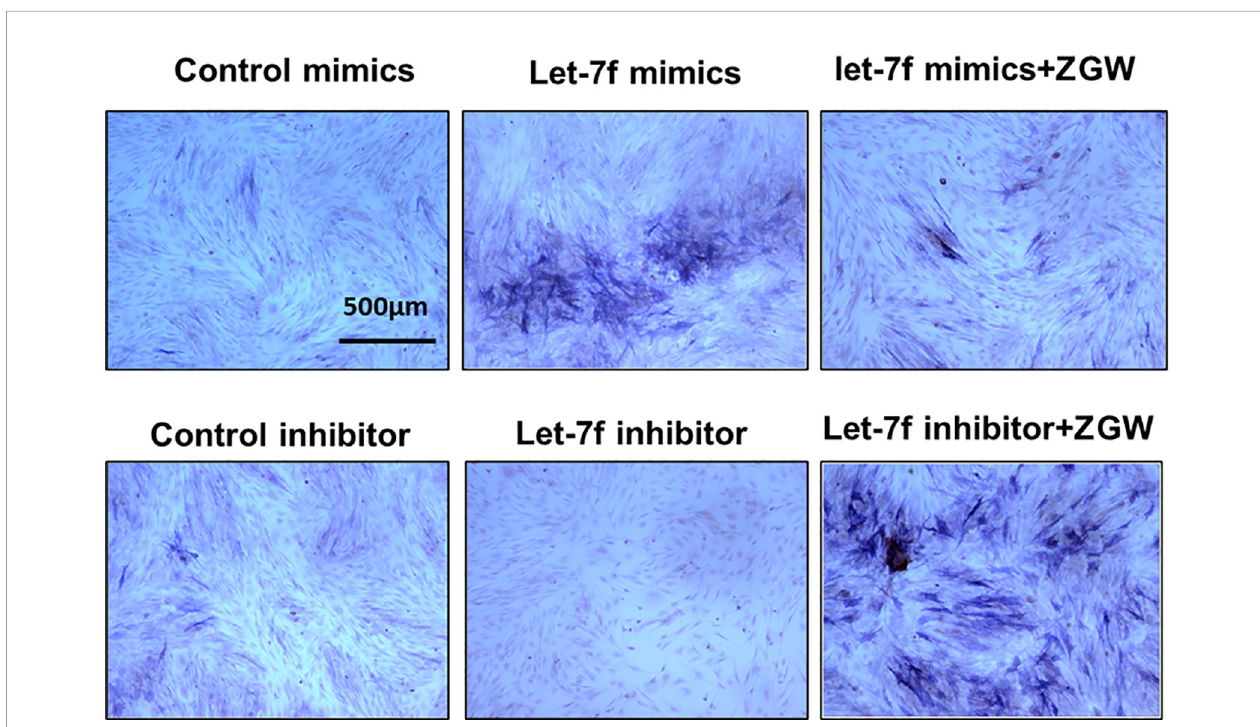
FIGURE 7 | The osteoblast differentiation ability of BMSCs was evaluated by ALP staining. Scale bars are displayed on the images. Magni fi cations: